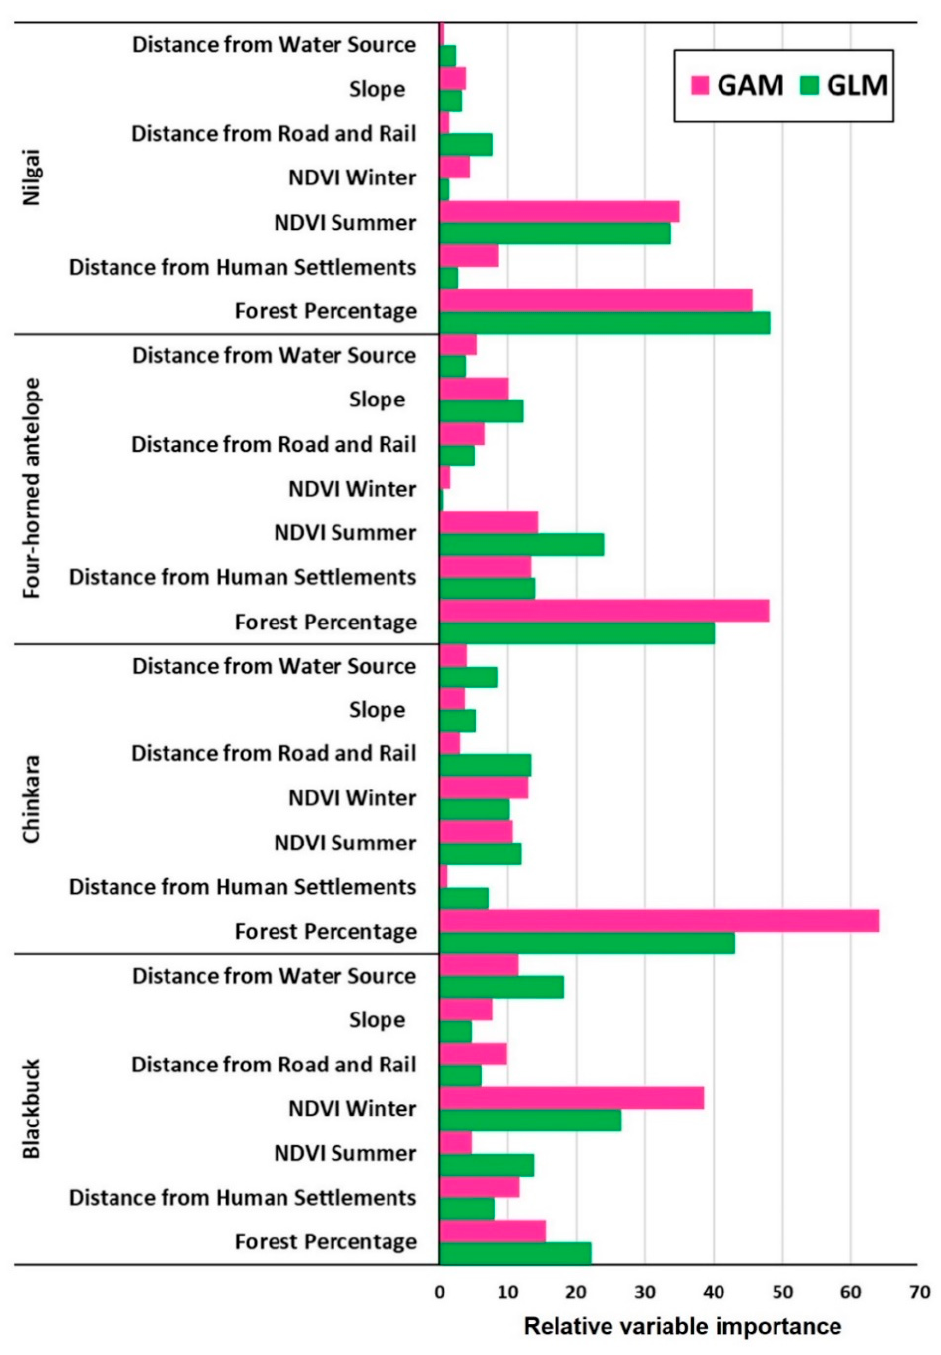
Figure A1. Variable importance for habitat suitability. Forest percentage is the most important variable for all antelopes except blackbuck, for which the most important it the post-monsoon NDVI. Pre-monsoon NDVI is an important variable for nilgai and four-horned antelope. Distance from water is a relatively more important factor for blackbuck as compared to the other